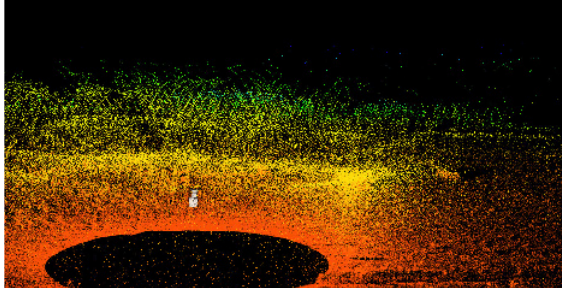
Figure 8: Landing zone raw lidar data including dust and above ground objects.